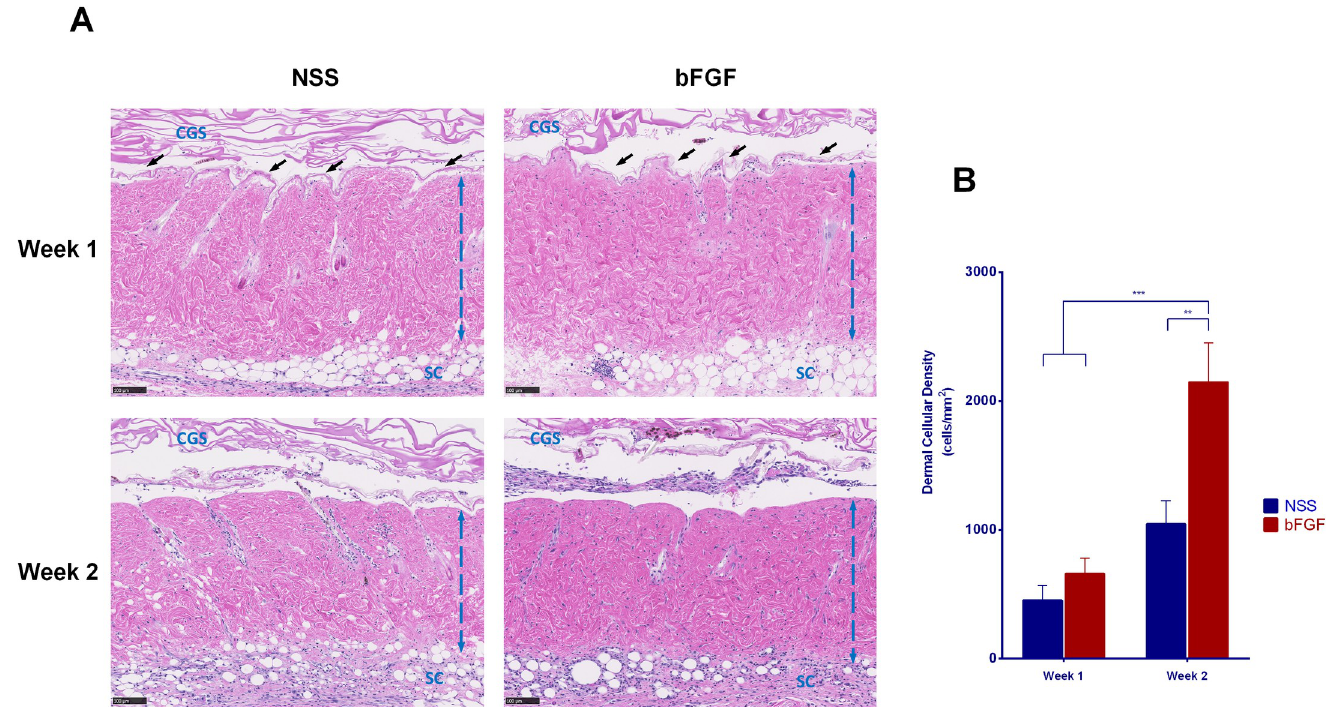
Fig 2. The infiltration of recipient cells into inactivated dermis after implantation. (A) Micrographs of HE-stained sections of skin grafts at Weeks 1 and 2 after implantation. The original dermal cell remnants were absorbed, and the epidermis indicated by black arrowheads was detached from the papillary dermis at Week 1. Cells from recipients showed infiltration to the dermis, and the dermal cellular density increased over the time. No inflammation reactions or dermal collagen fiber degeneration was observed. The blue broken lines indicate the dermis of grafts, CGS: collagen gelatin sponge after implantation, SC: subcutaneous layer; magnification: 10x, scale bar: 100 μ m. (B) The diagram shows significant differences in the dermal cellular density of the bFGF group between Weeks 1 and 2 ( ��� p < 0.001); the dermal cellular density of the bFGF group at Week 2 was significantly higher than that in the NSS group ( �� p < 0.01).